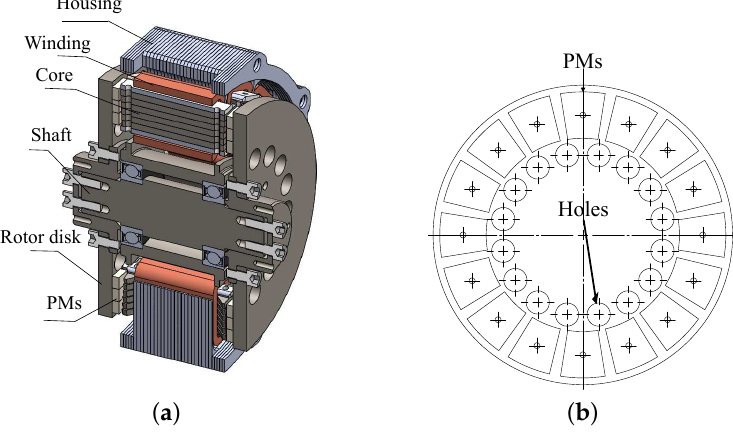
Figure 2. Prototype and rotor structure: ( a ) Prototype cross-section; ( b ) Rotor geometry. PM: permanent magnet.